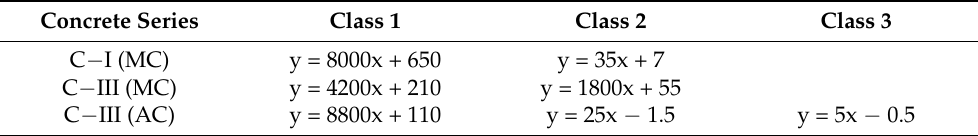
Table 3. Equations of linear functions of the correlation between strains and number of hits. Concrete Series